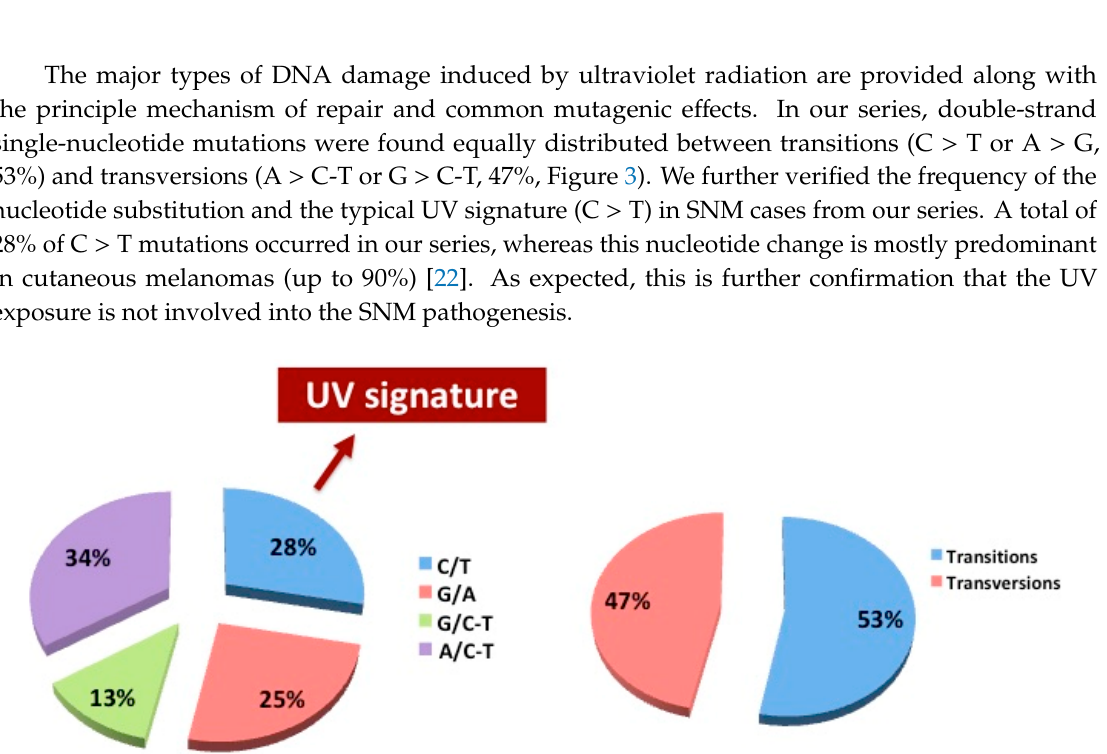
Figure 2. Type of non-synonymous sequence variants per gene. The graph summarises the number of pathogenic mutations (light blue bars), variants of unknown significance (red bars), and single-nucleotide polymorphisms (green bars) found in each individual gene analysed. ns-SNV, non-synonymous single nucleotide variants. VUS, variant of unknown significance. Mutations are intended as pathogenic variants.